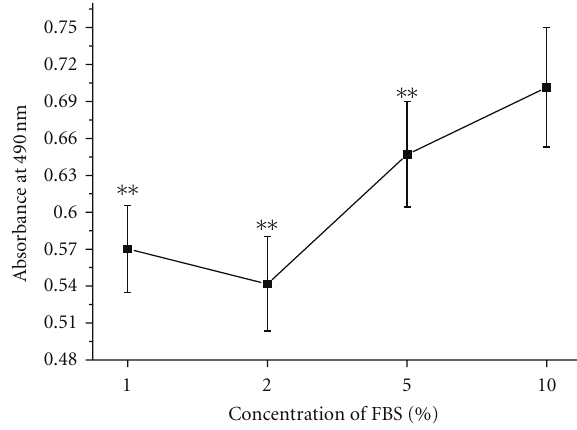
Figure 1: The cell proliferation of HeLa cells in di ff erent FBS concentrations without laser irradiation. Error bars were from three independent experiments. ∗∗ P < 0 .